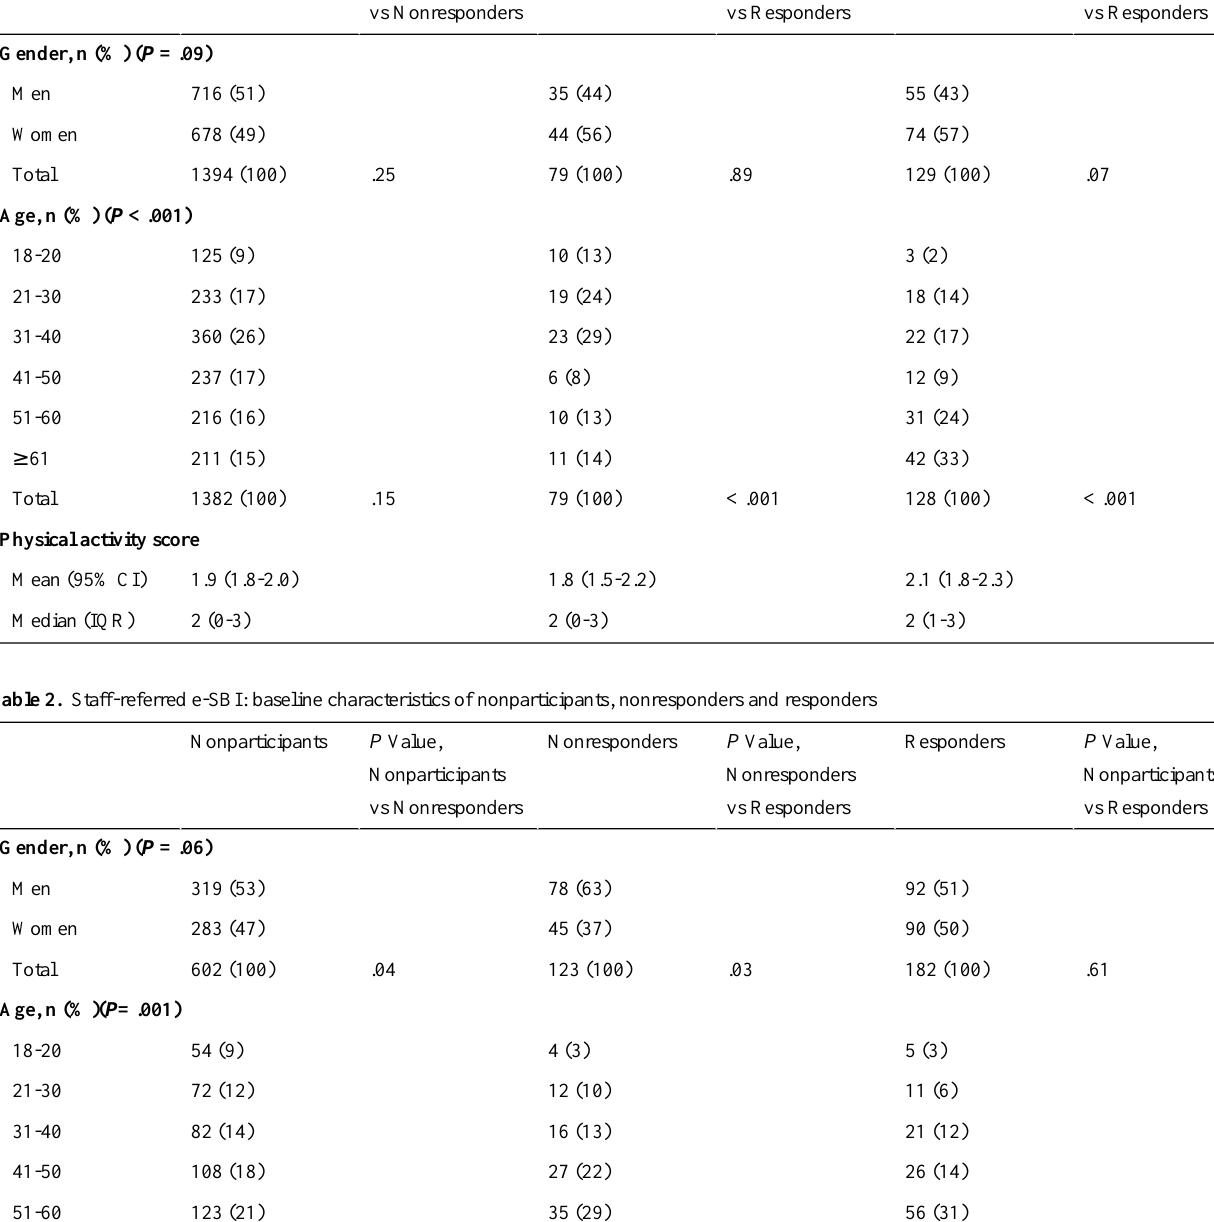
Table 1. Patient-initiated e-SBI: baseline characteristics of nonparticipants, nonresponders, and responders